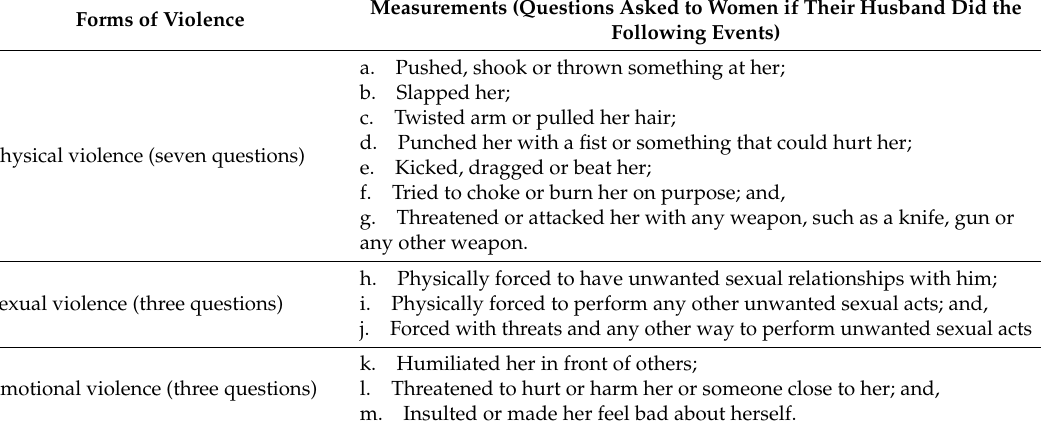
Table 1. Measurement of outcome